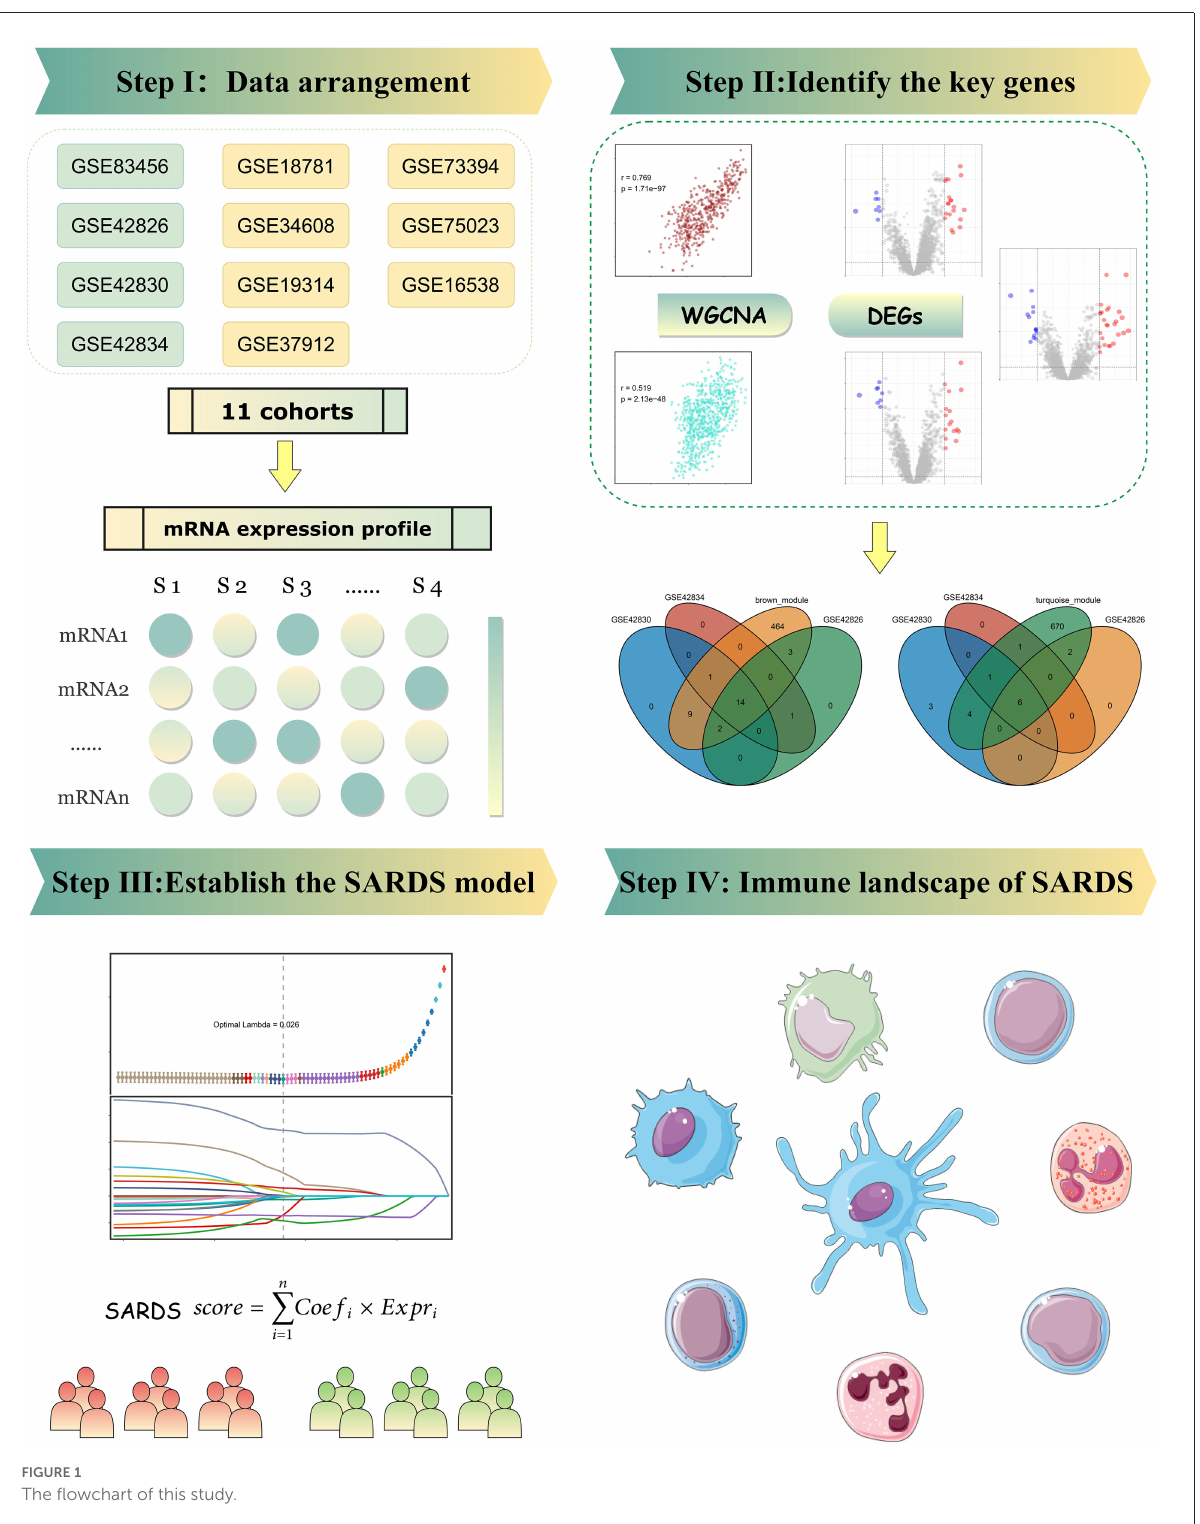
transformed into a topological overlap matrix (TOM) and a 1- TOM, reflecting the similarity and dissimilarity between genes separately. MinModuleSize was set to 50 to ensure each module